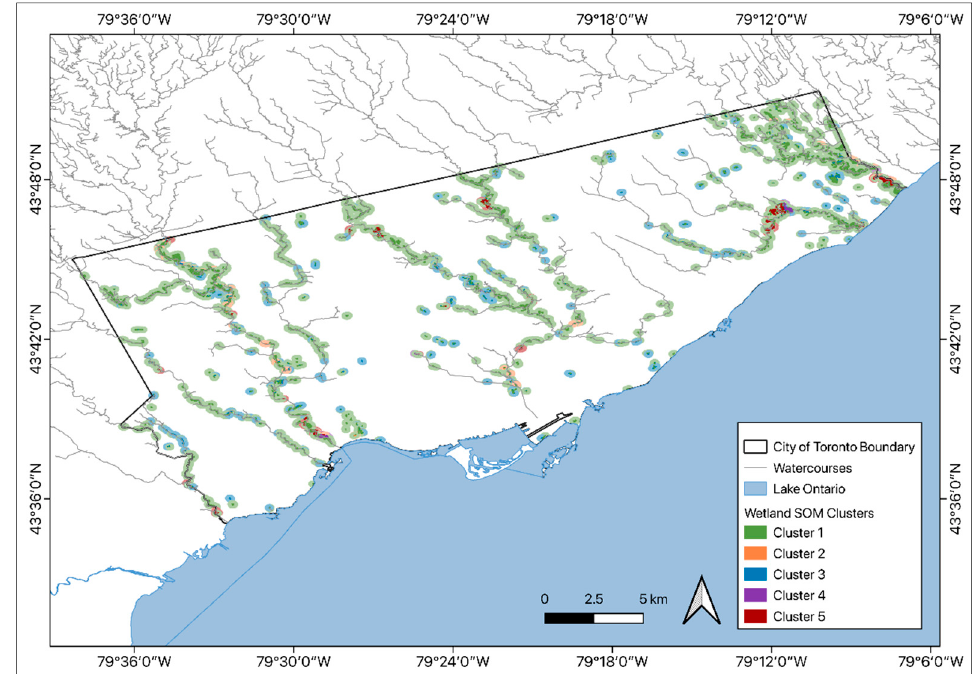
Figure 7. Toronto wetland SOM clusters.